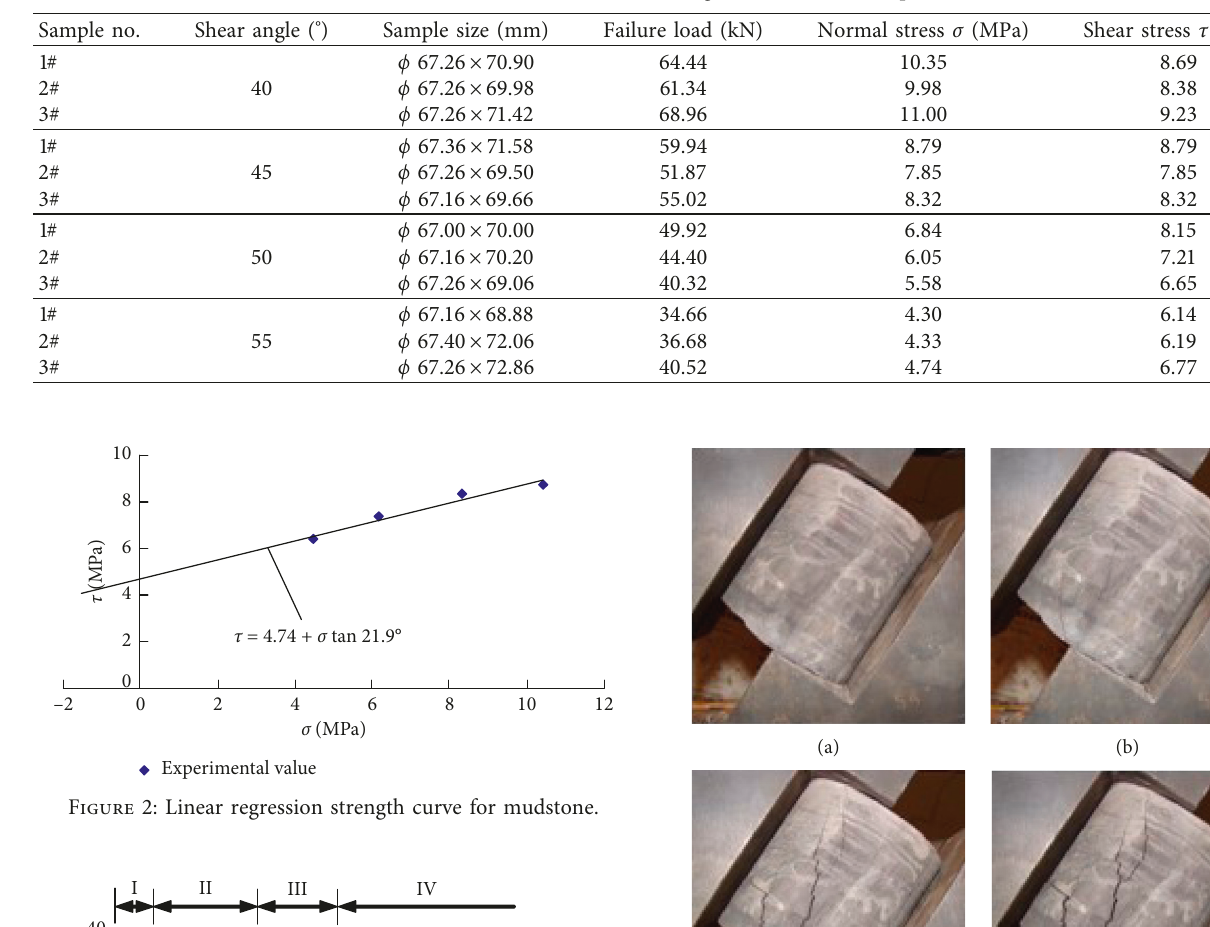
Table 1: Test results for shear strength of mudstone samples.